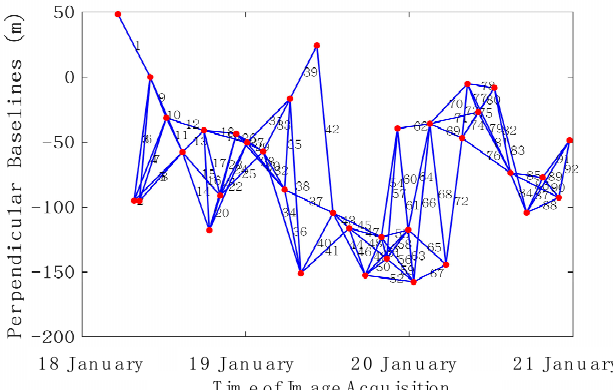
Figure 3. Time-position of Sentinel-1A image interferometric pairs. Blue line represents the interferometric pairs. The red points are the master and slave Synthetic Aperture Radar (SAR) images.